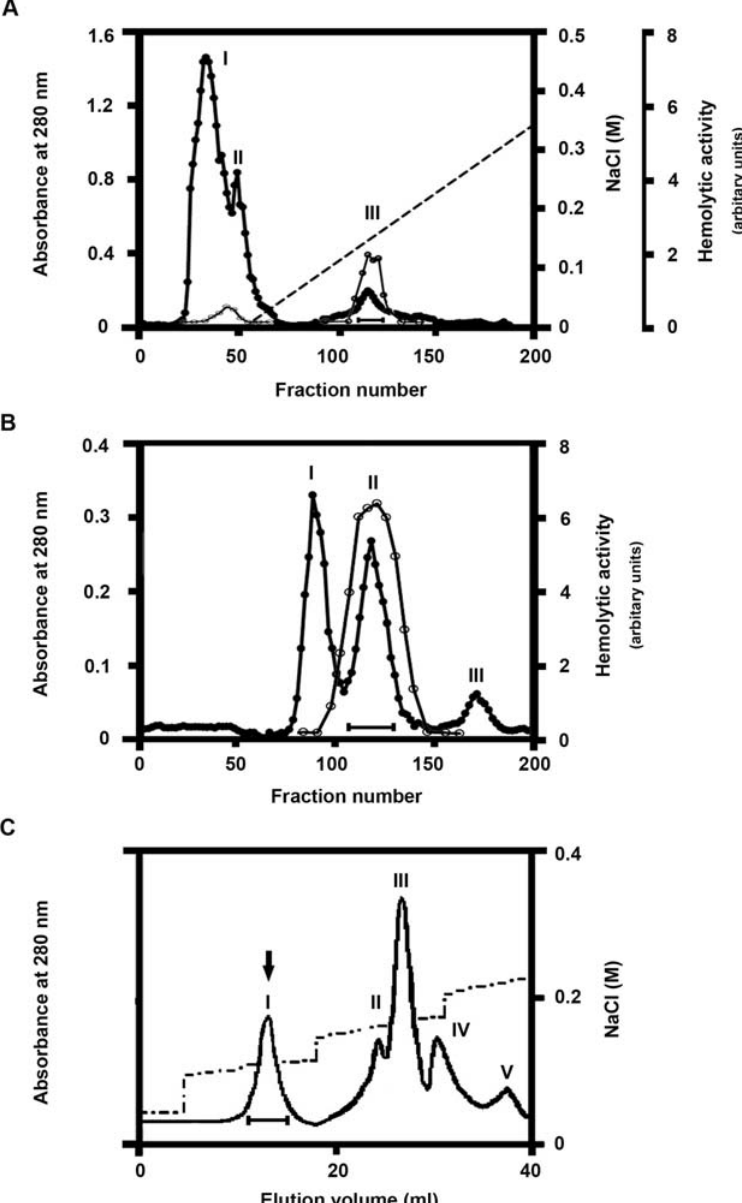
Figure 1. Purification of bc -CAT. (A) Lyophilized frog B. maxima skin secretions (5.0 g, containing 550 mg proteins, from a stock in Kunming Institute of Zoology) was dissolved in 10 ml 50 mM Tris-HCl buffer, pH 7.3, containing 5 mM EDTA, dialyzed against the same buffer at 4 u C overnight and centrifuged. The supernatant was loaded on a DEAE Sephadex A-50 (Pharmacia) column (2.6 6 50 cm). The elution was performed at a flow rate of 30 ml/h with a linear NaCl gradient, collecting fractions of 5 ml per tube. Hemolytic activity was mainly found in NaCl-eluted peak III. This peak was collected as indicated by a bar. (B) The peak III from DEAE Sephadex A-50 column was concentrated, then applied on a Sephadex G-100 (Pharmacia, superfine) column (2.6 6 100 cm) equilibrated with 50 mM Tris-HCl buffer, pH 7.8, containing 150 mM NaCl and 5 mM EDTA. Elution was achieved with the same buffer at a flow rate of 12 ml/h, collecting fractions of 2 ml per tube. The hemolytic activity was found in peak II. In A and B, The protein concentration was estimated from the absorbance at 280 nm ( N ). The hemolytic activity on human erythrocytes ( # ) was determined as described in ‘‘Methods’’. (C) The peak II of Sephadex G-100 column was lyophilized and dialyzed against 25 mM Tris-HCl, pH 7.8, for 24 h at 4 u C, and finally applied on an AKTA Mono-Q HR5/5 anion ion exchange column equilibrated with the same buffer. Elution was performed at a flow rate of 1.0 ml/min with the NaCl gradient, as shown in the figure. Hemolytic activity was found in peaks I, II and III. Peak I is highly purified bc -CAT, as indicated by an